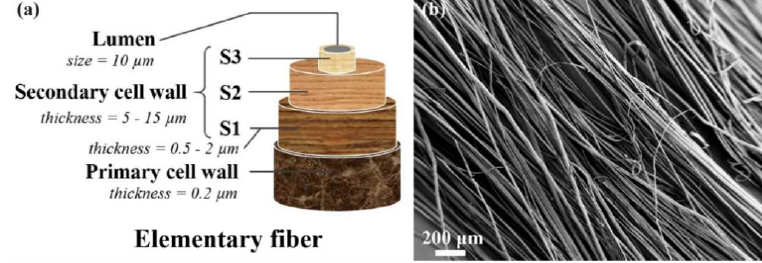
Figure S1 of the Supporting Information. The results obtained are in line with what was already reported for flax [29,30].